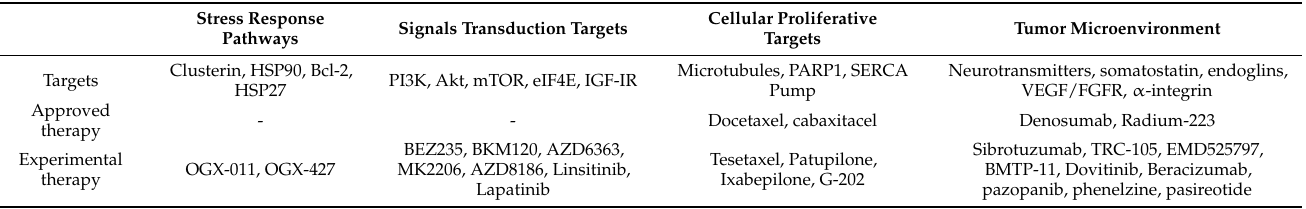
Table 2. Selected approved and experimental therapeutics agents for CRPC targeting non-AR axis (clinicaltrials.gov, accessed on 10 February 2021), adapted from Reference